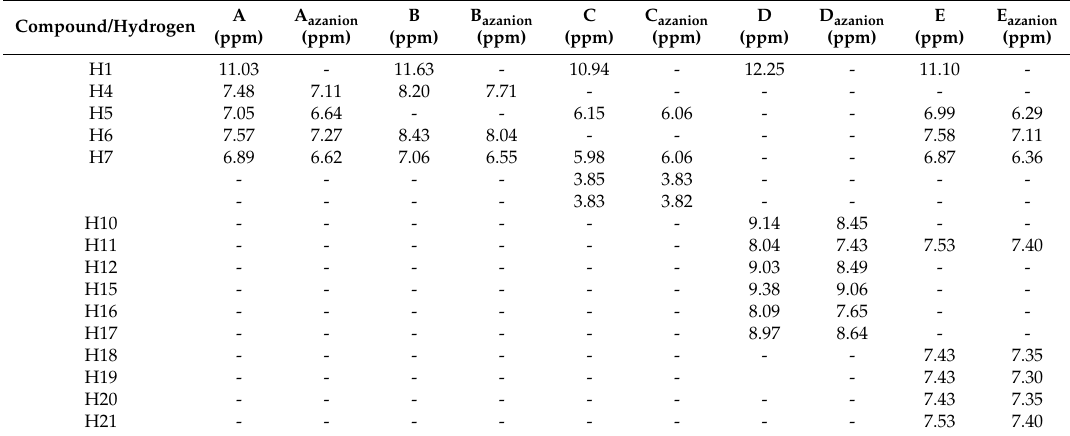
Table 4. Chemical shifts of the A – E isatin derivatives and their azanions in 1 H-NMR in DMSO. A A azanion Compound/Hydrogen (ppm) (ppm)